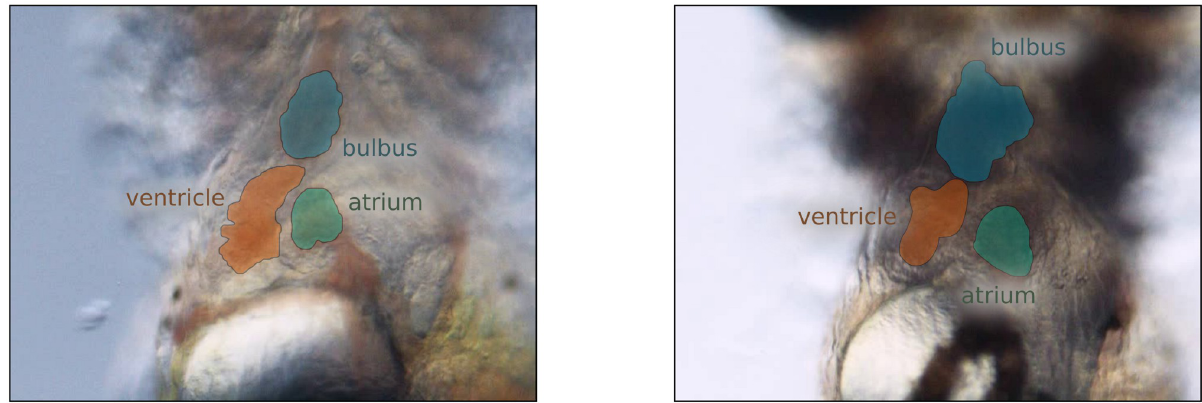
Fig 2. Labels of the extended heartSeg dataset. Displaying image masks for the three semantic classes overlaid on two image samples of the medaka hatchlings’ cardiac system as part of the extended heartSeg dataset. The orange label masks depict the ventricle V (based on the heartSeg dataset [3]). The blue and green label masks depict the respective, newly added semantic classes bulbus B and atrium A